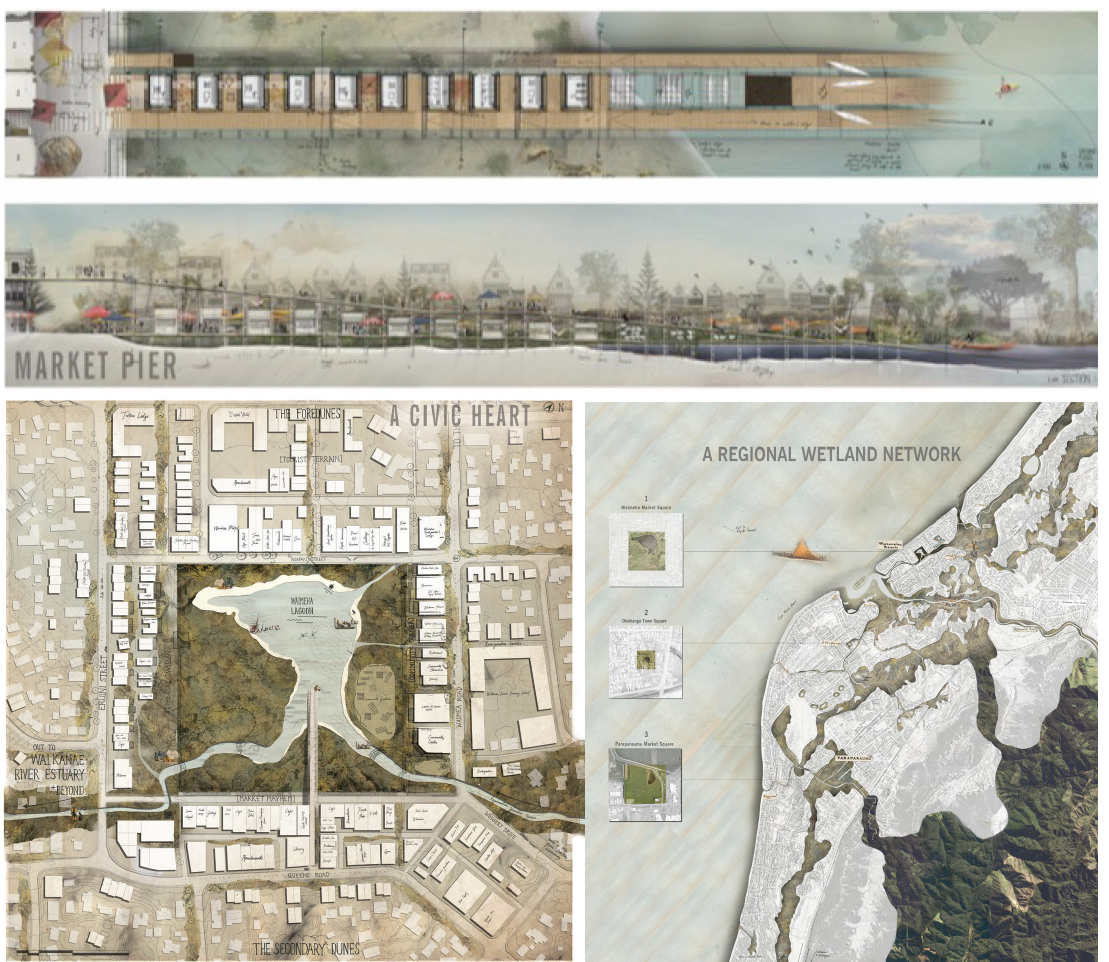
Figure 3. Wetland Square a speculative design by Rachel Murray. Anticlockwise from top: Plan of pier; elevation of pier with new town centre buildings behind; plan of proposed Wetland Square ; regional plan of Wetland Squares. Source: Rachel Murray .